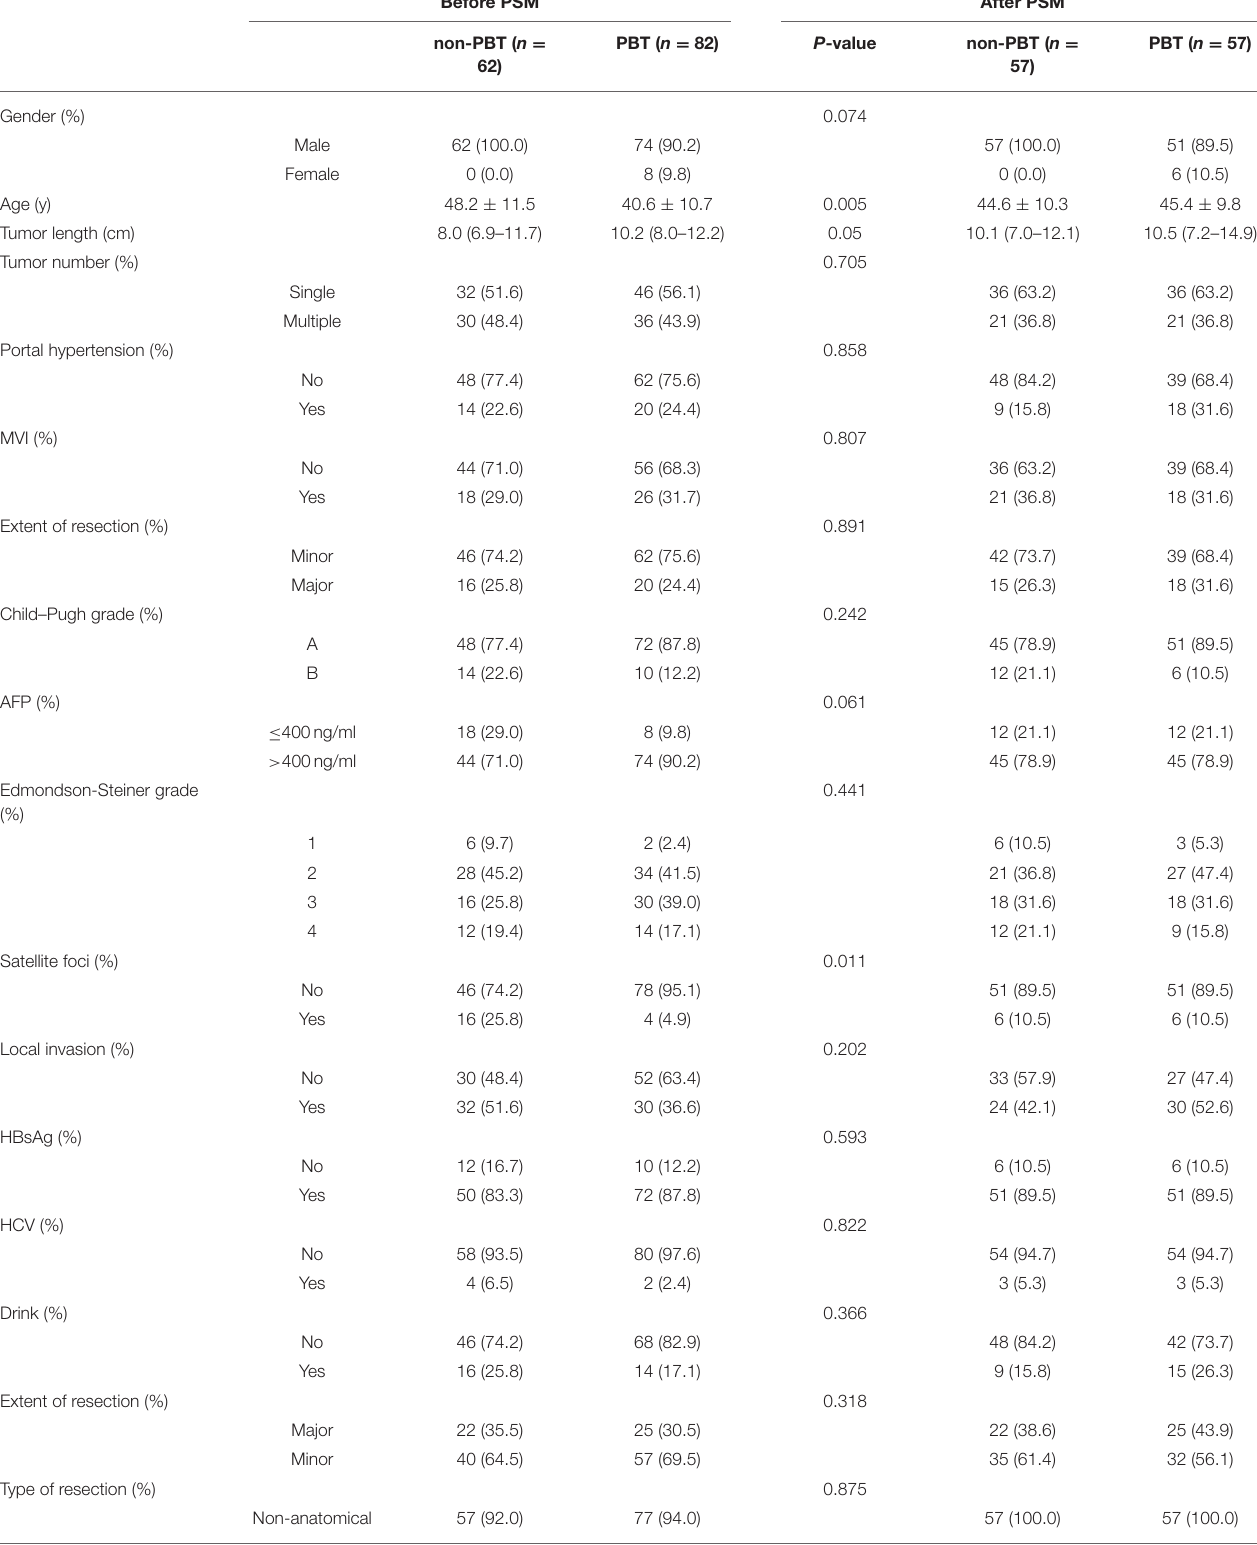
TABLE 2 | Clinicopathologic characteristics of rHCC patients with early-stage (BCLC stages B and C)